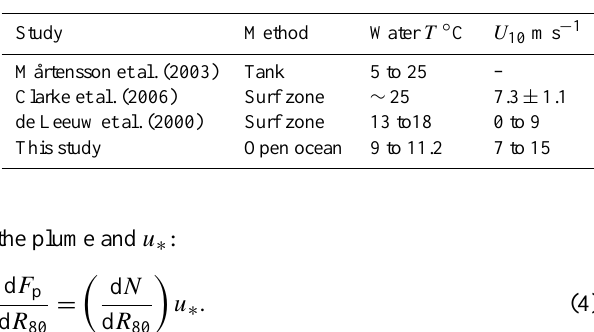
Table 2. Summary of the main studies discussed in this paper.